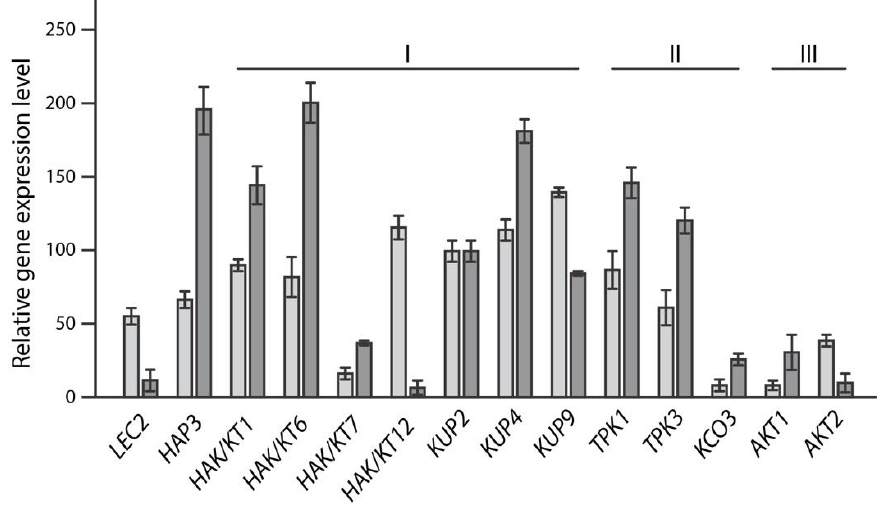
Figure 1. Relative expression of K + transporter/channel genes. Displayed are genes that are expressed during seed development (GEO dataset GSE5634). As references, the expression values of LEC2 (At1g28300) and HAP3 (At2g38880) are given. Light grey bars show relative expression levels for siliques with seeds at stage 4 (heart cotyledons), whereas the dark grey bars represent gene transcription levels in seeds without siliques at developmental stage 9. The genes are ordered with respect to their family affiliations. I, KT/HAK/KUP-type transporters; II, voltage-independent tandem pore K + (TPK) channels; III, voltage-gated shaker -like K + channels.